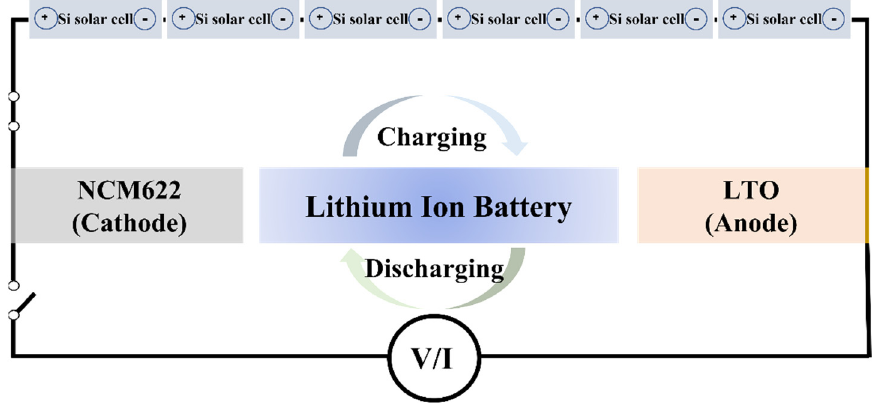
Figure 5. Schematic diagram of the NCM-LTO integrated device with Si solar cells.